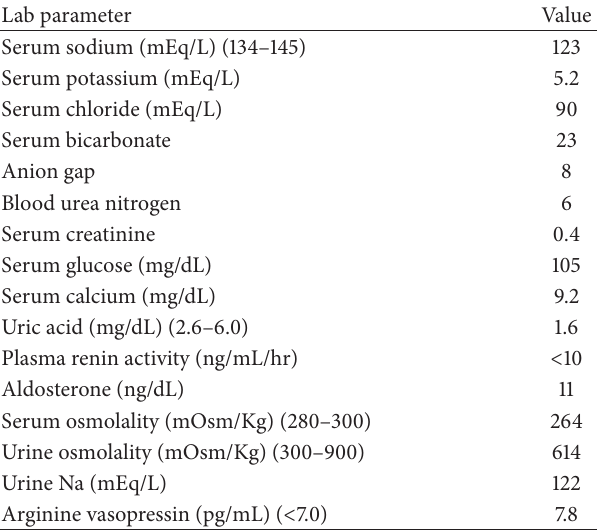
Table 1: Serum and urine chemistry at initial